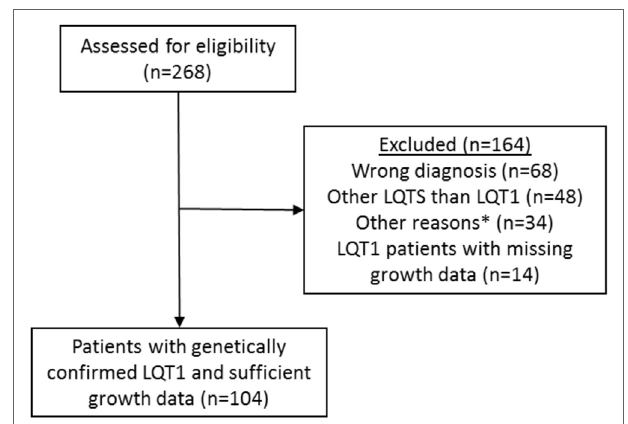
FigUre 1 | Identification and verification process of the patients with long QT syndrome 1 (LQT1) due to KCNQ1 mutations at the Children’s Hospital, Helsinki University Hospital. Medical records of 104 patients with genetically verified LQT1 and growth data were identified. See main text for details. *Miscellaneous reasons such as patient’s medical records were not